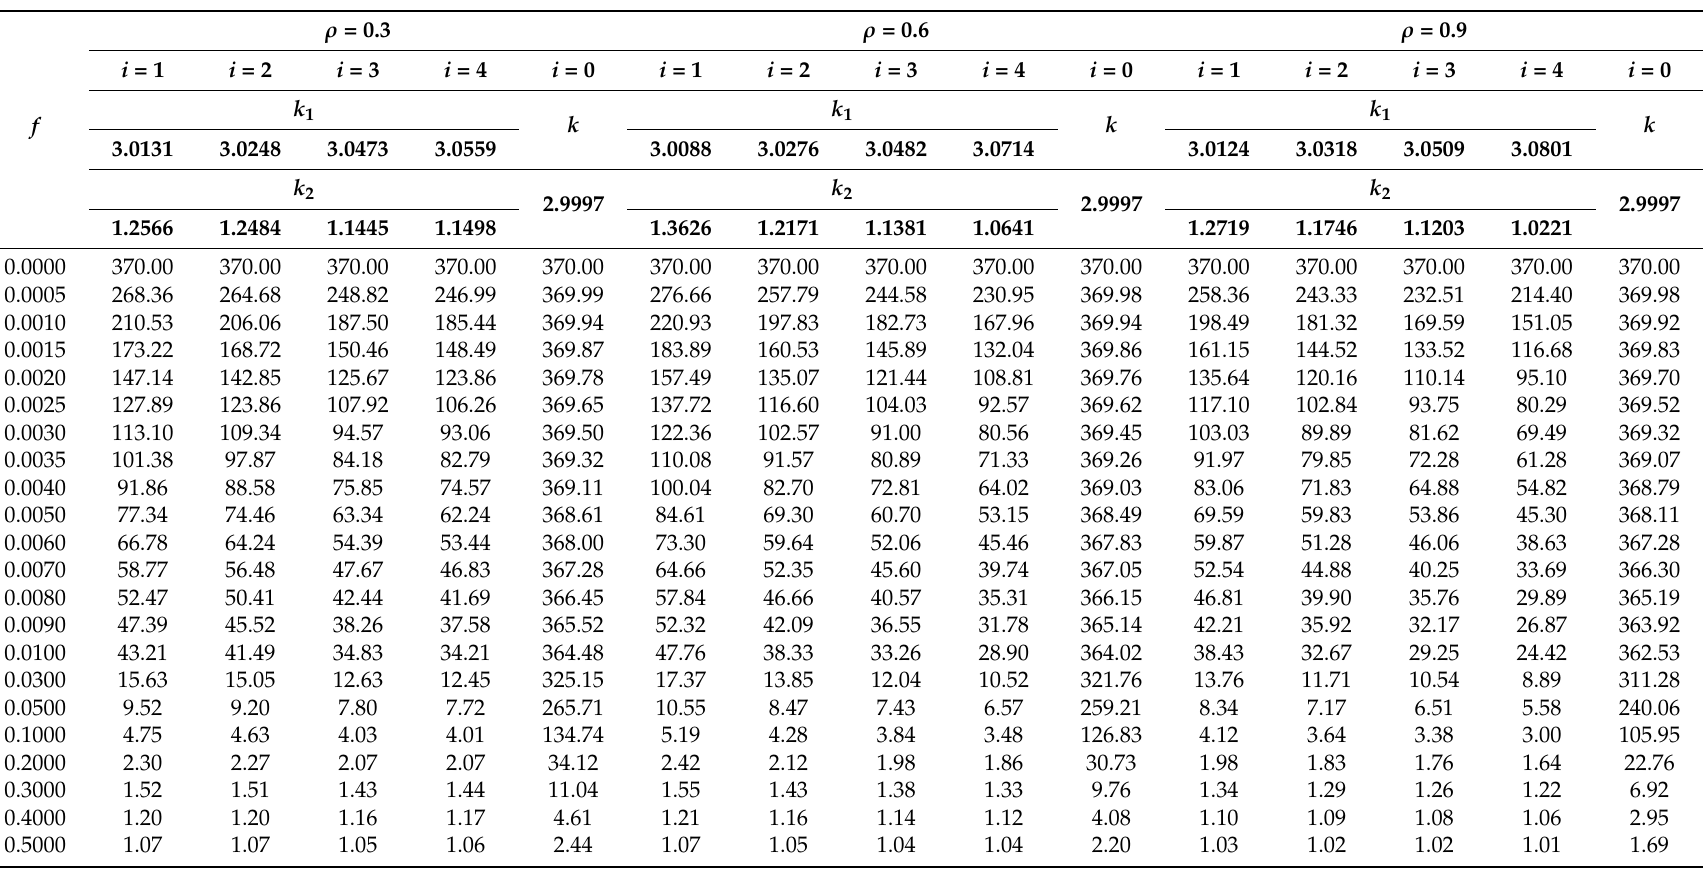
Table 5. The ARL analysis for 370 with n =